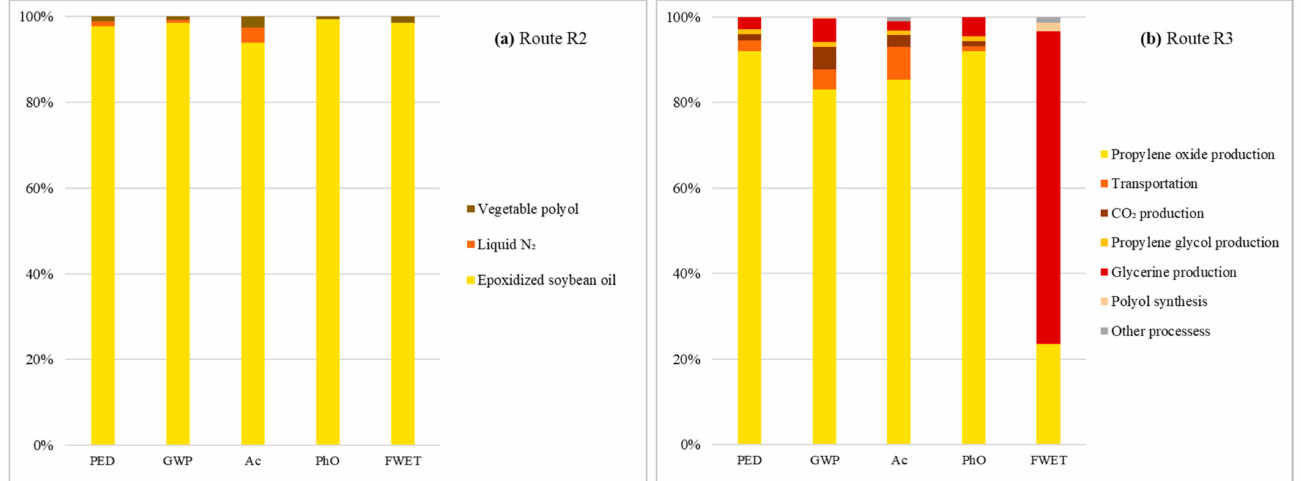
Figure 3. Cumulative contributions per impact category of R2 ( a ) and R3 ( b ) life cycle